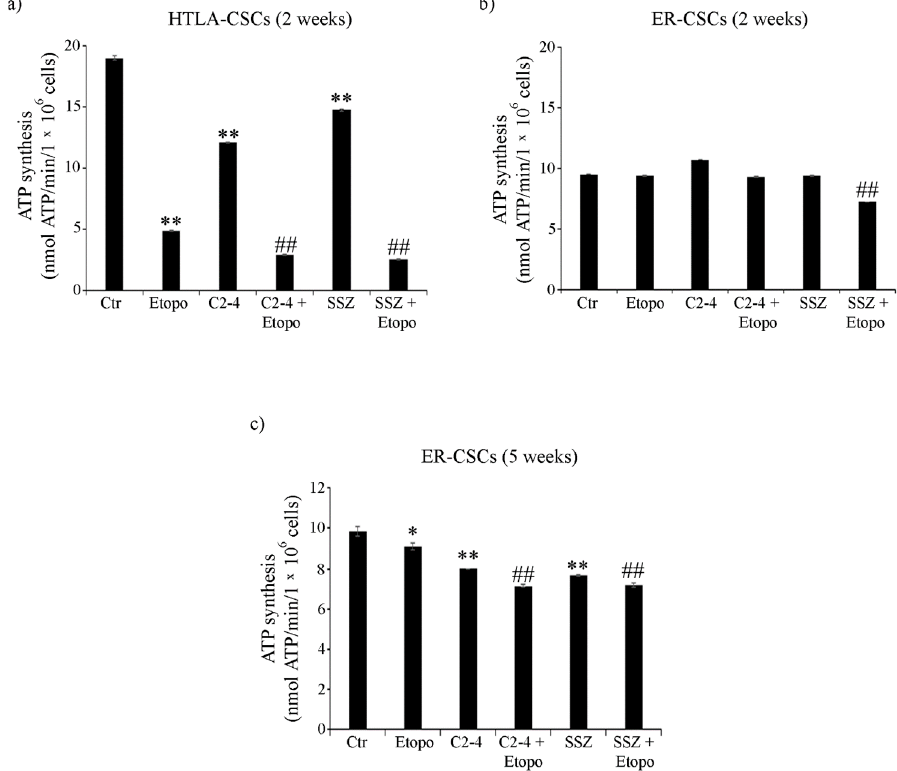
Figure 4. ATP synthesis in both CSC populations treated for two ( a , b ) or five weeks ( c ). HTLA-CSCs and ER-CSCs were treated three times a week with 0.1 µ M C2-4, with 5 µ M SSZ or with 1.25 µ M Etoposide, administered once a week alone or in combination with C2-4 or SSZ. Results were reported as nmol ATP/min/10 6 cells. Bar graph summarizes quantitative data of means ± S.E.M. of three independent experiments. * p < 0.05 vs. untreated CSCs (Ctr); ** p < 0.01 vs. untreated CSCs (Ctr); ## p < 0.01 vs. Etoposide-treated CSCs.